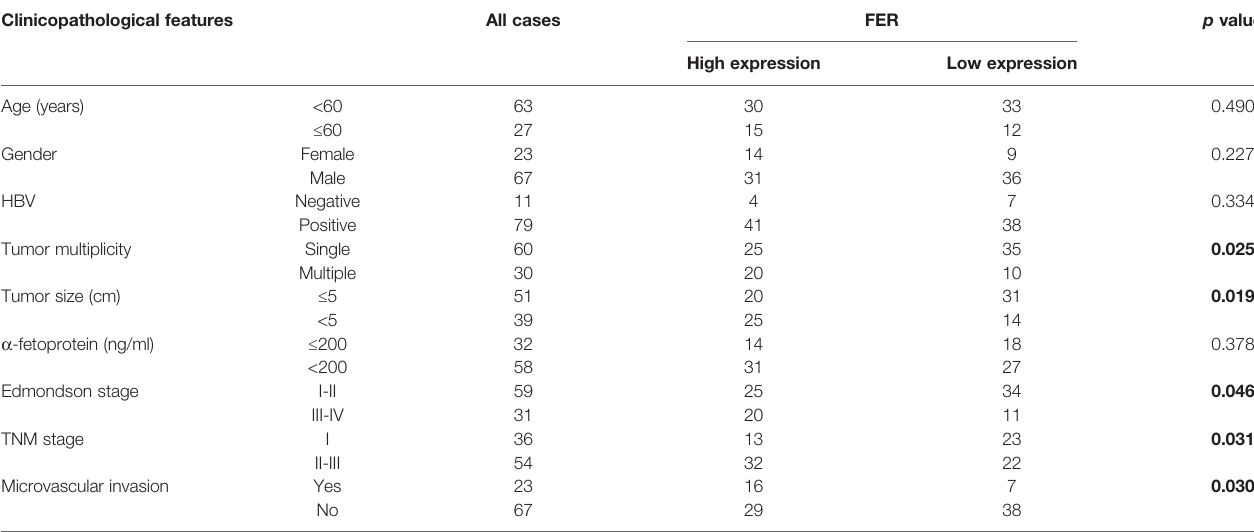
TABLE 1 | Correlation between FER expression and clinicopathological features. Clinicopathological features All